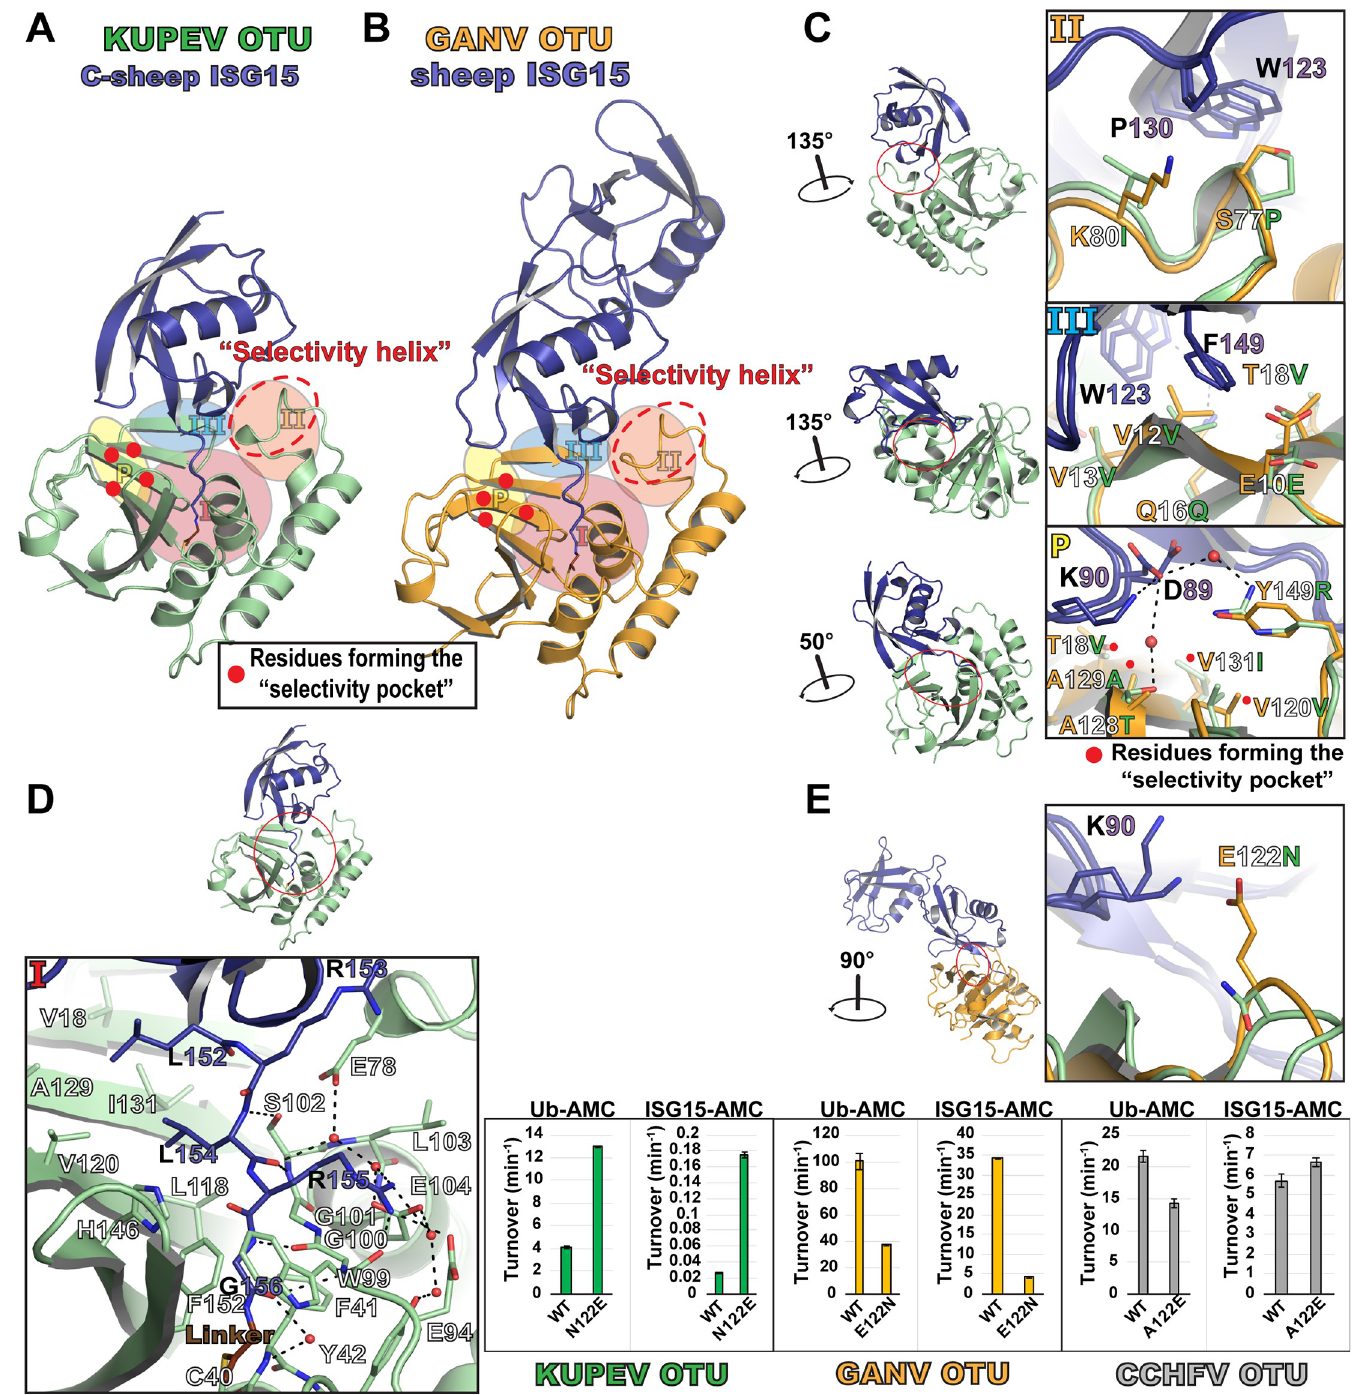
Fig 3. Structures of the KUPEV and GANV OTUs in complex with sheep ISG15. (A) A cartoon rendering of the KUPEV OTU (green) bound to the C-terminal domain of sheep ISG15 (purple). The propargylamine molecule covalently linking the ISG15 and OTU is shown in brown. The regions of the OTU forming the interface with sheep ISG15 are indicated by a shaded background. The approximate locations of residues forming the selectivity pocket are indicated by red dots. The secondary structure for KUPEV OTU as calculated by the DSSP server is indicated [71]. (B) A cartoon rendering of the GANV OTU (orange) bound in complex with sheep ISG15 (purple), annotated as in (A). (C-D) Closeup views of major interactions within the three main regions (I-III) and peripheral regions (P) of the KUPEV/GANV interface with sheep ISG15. Black dashes indicate interatomic distances � 3.5 Å between atoms capable of forming electrostatic pairs. (E) A closeup of residue 122 in the KUPEV and GANV OTUs, with the impact of mutating this residue measured by activity towards Ub-AMC and human ISG15-AMC. Values are the mean ± standard deviation of two independent experiments.